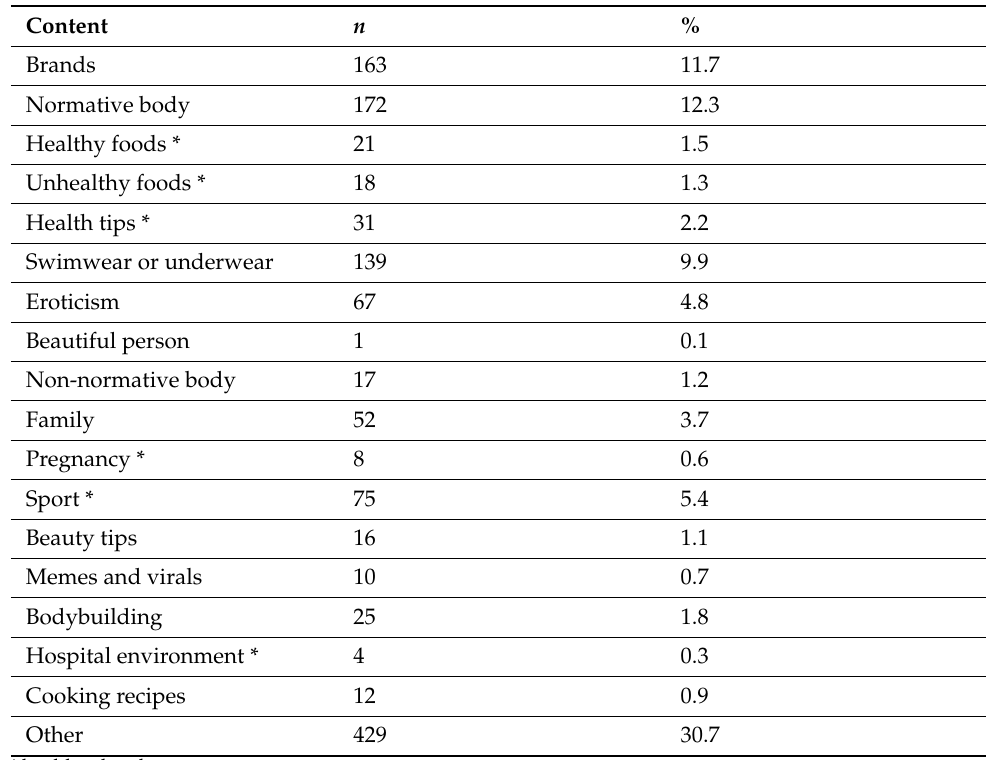
Table 3. Content published by the influencers analysed. Source: own